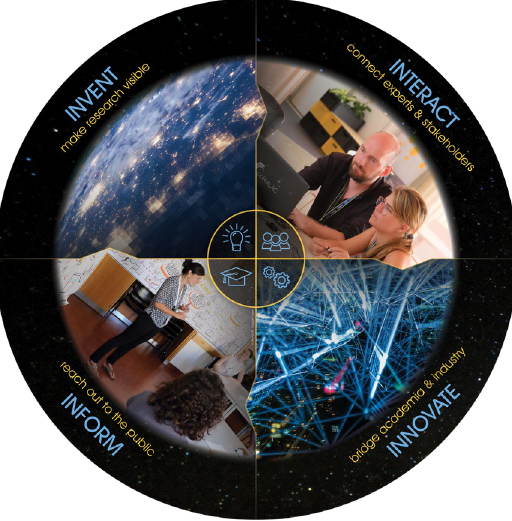
Figure 1. Core activities around the Copernicus